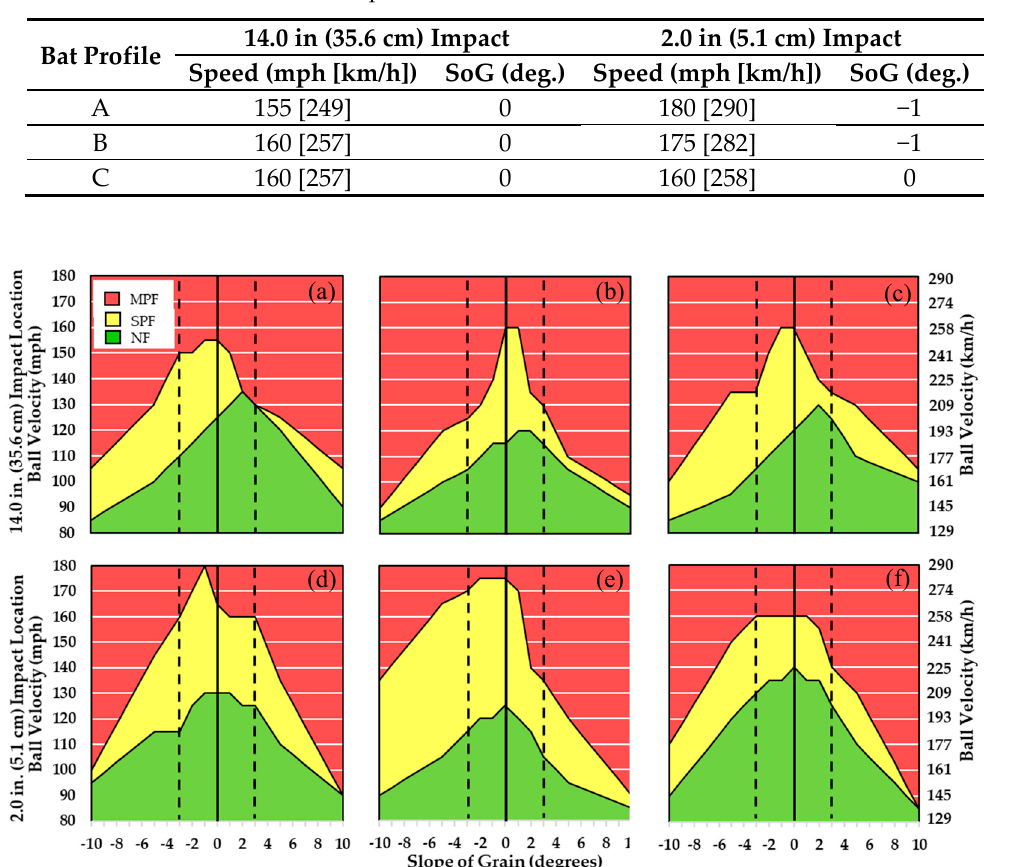
Table 5. Peak speed and associated SoG for SPF outcome.